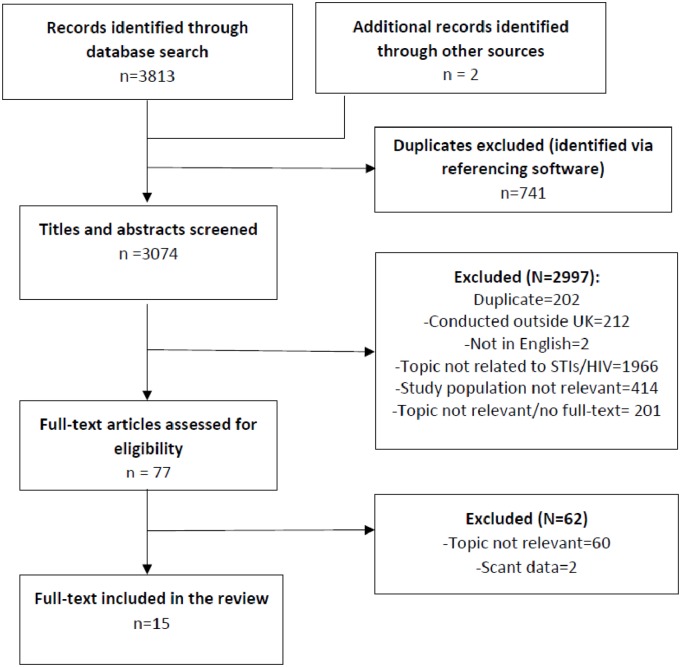
Flow diagram of records screening for identifying eligible studies.